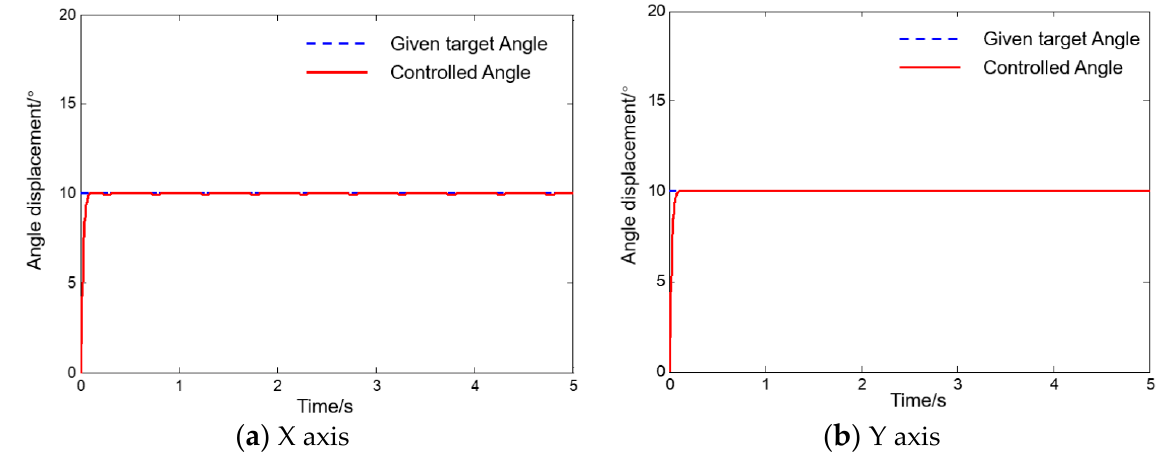
Figure 10. Tracking test results at a given angle.